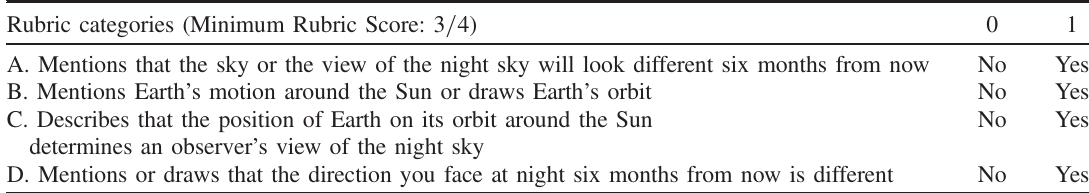
Rubric categories (Minimum Rubric Score: 3 = 4